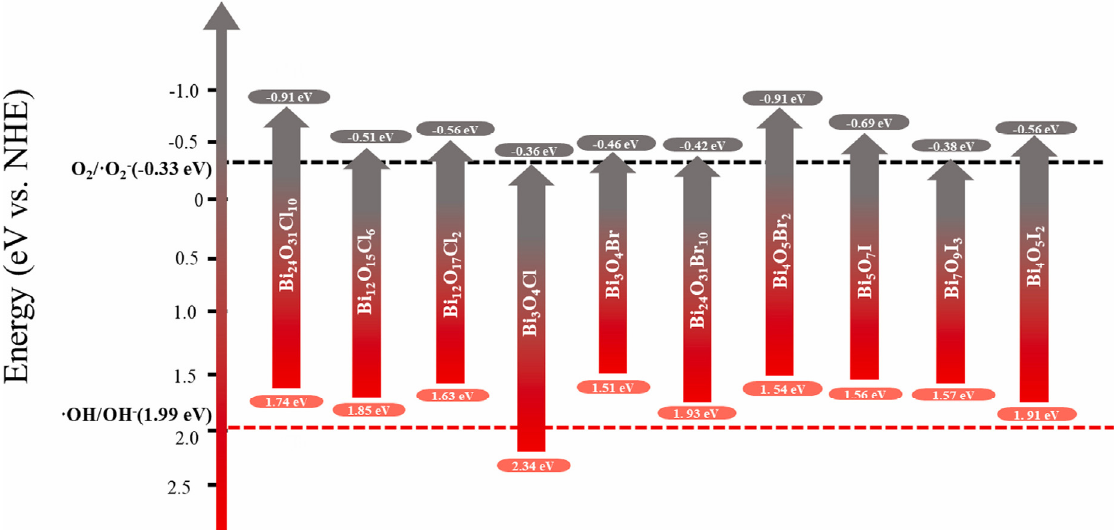
Figure 8. Band gap structure of few important oxyhalide photocatalysts. Reproduced with permis- sion [123], Copyright 2021, Elsevier.